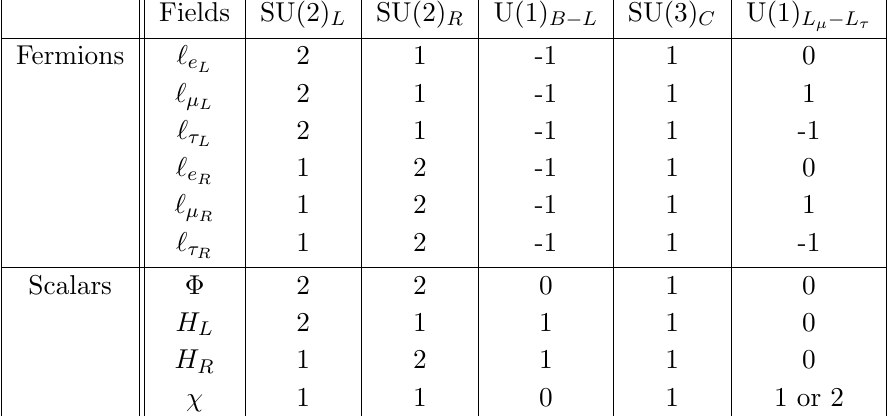
gauge symmetry where (cid:22) (cid:0) L (cid:28)